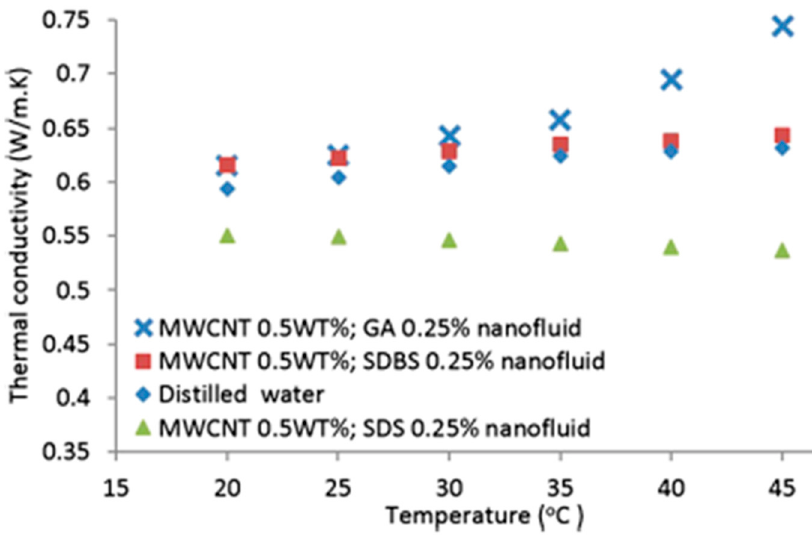
Figure 8. Influence of different surfactants (GA, SDBS, and SDS) thermal conductivity of aqueous MWCNT nanofluids [126].